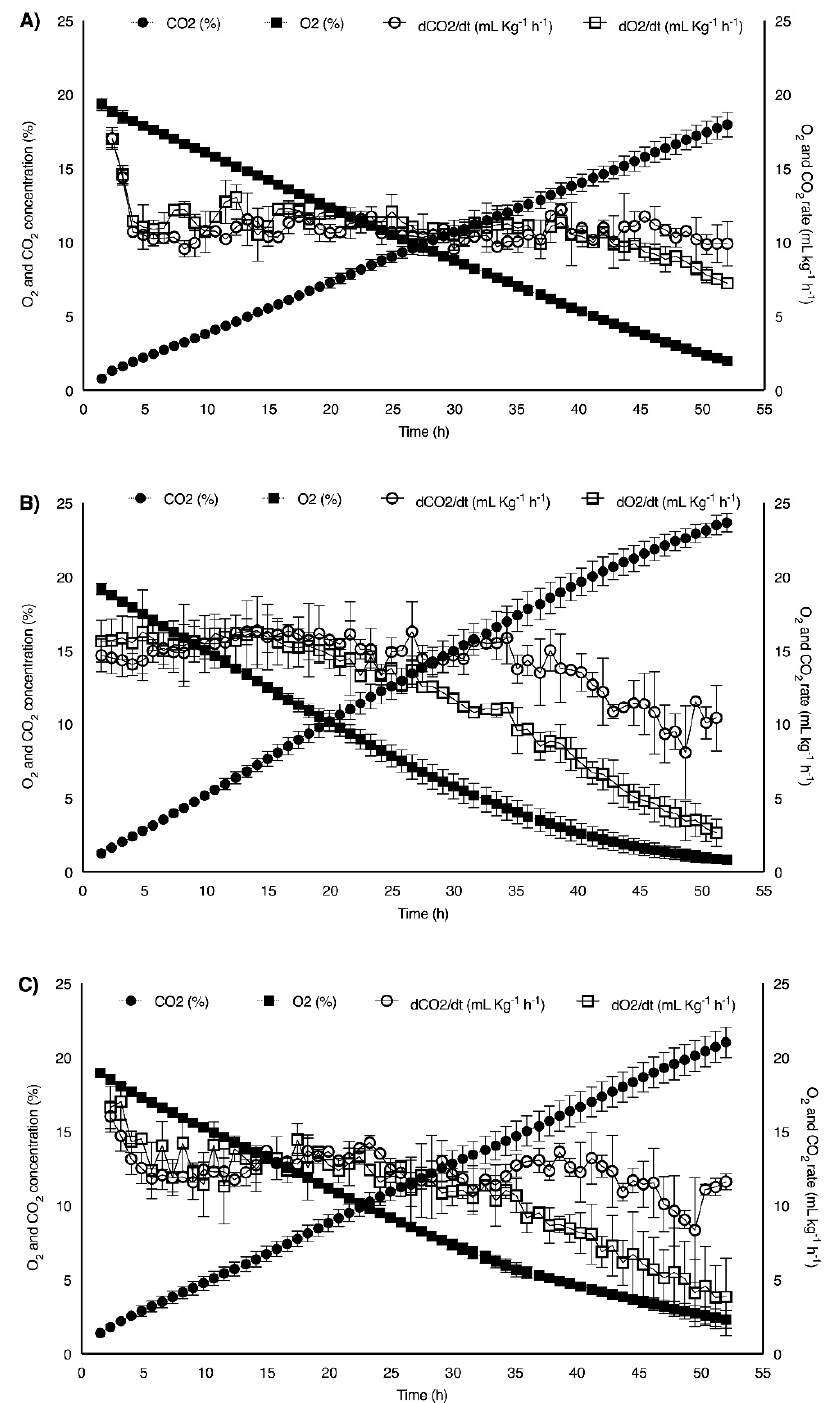
Figure 1. O 2 and CO 2 concentration, and calculated respiration rates of: ( A ) controls, ( B ) UV1 (2 kJ m − 2 ) and ( C ) UV2 (4 kJ m − 2 ) treated raspberries. Values represent mean ± standard deviation ( n = 3).